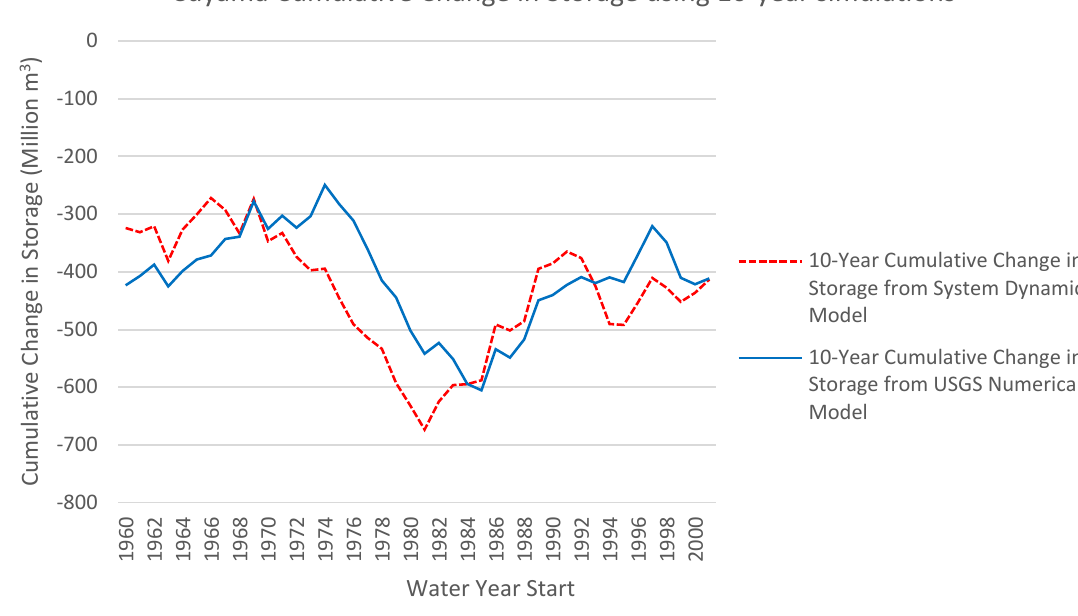
Figure 8. Cuyama Basin 10-year groundwater system simulation.